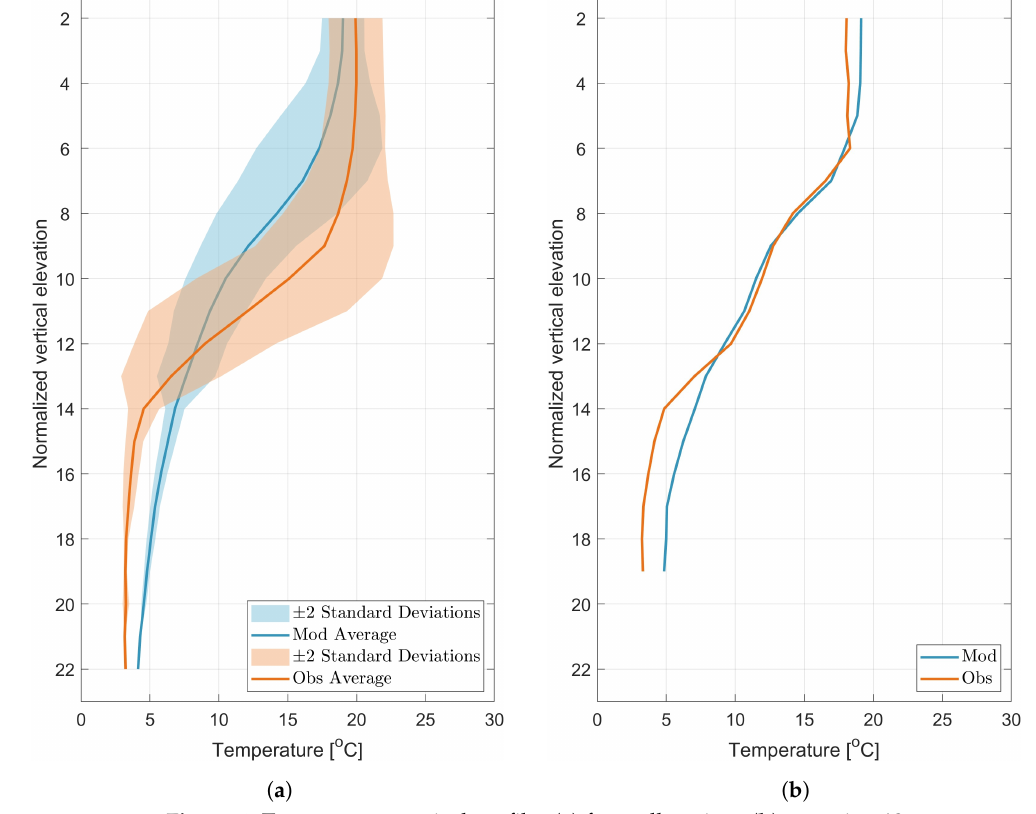
Figure 4. Temperature vertical profiles ( a ) from all stations ( b ) at station 13. Table 4. Statistical comparison between model results and in situ measured water temperature at the surface level